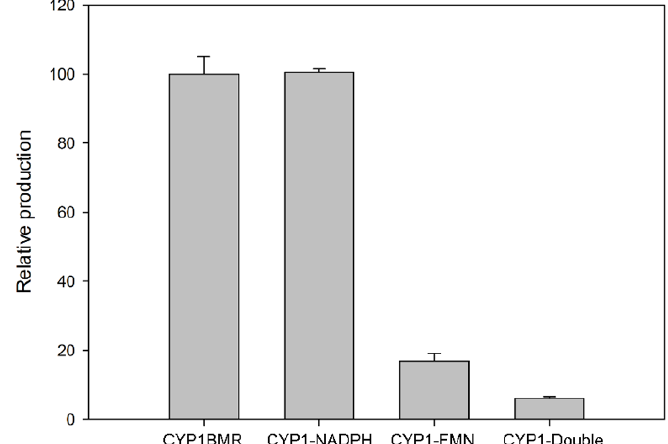
Figure 3. C16:0 sophorolipid production by strains harboring the non-mutated chimeric protein CYP1BMR and mutations in the reduced nicotinamide adenine dinucleotide phosphate (NADPH) binding motif, flavin mononucleotide (FMN) domain, and both domains of the flavin adenine dinucleotide (FAD)/FMN-containing cytochrome P450 reductase (BMR). Error bars represent the standard deviation (SD; n = 3).